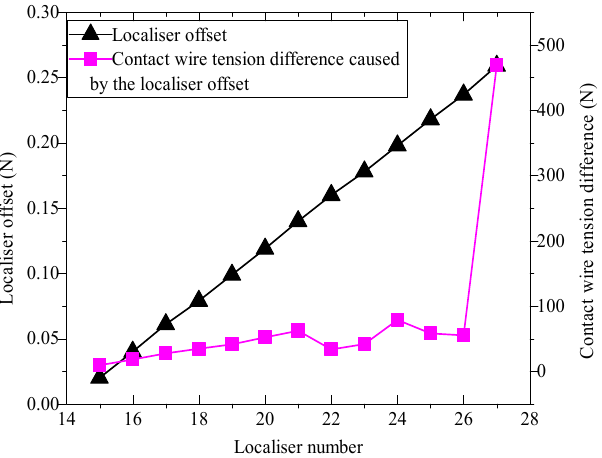
Figure 11. Localizer offset values of the 15–28th spans and contact wire tension difference. According to the above algorithm, when the contact wire mid-point anchor was in the 12th to 16th spans, in turn, the following forces were obtained: the tension difference of the contact wires ( ∆ T jwL and ∆ T jwR ) resulting from the offset of the localizers of the left and right half-anchor, the downslope component of the gravity ( ∆ G L and ∆ G R ) of the left and right half-anchor contact wires, the contact wire tension deviation ( Δ T j ) between both sides of the mid-point anchor, and these results are shown in Figure 12.